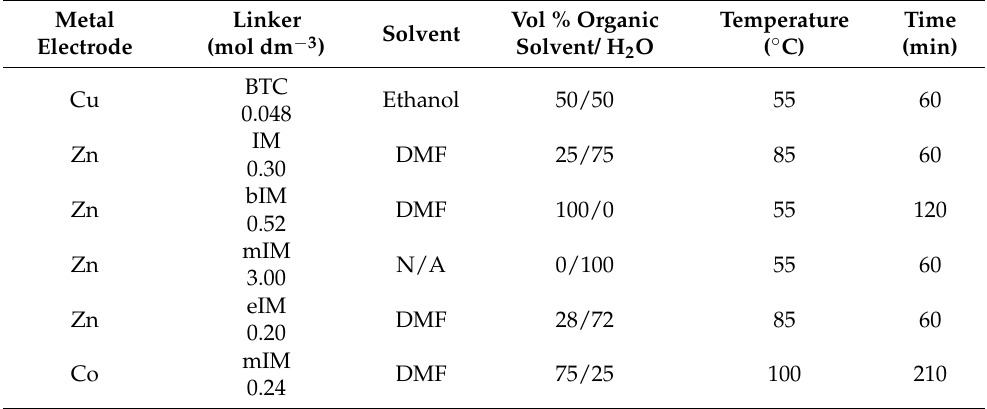
Table A1. Summary of the conditions used to produce a range of MOF coatings using traditional solvents